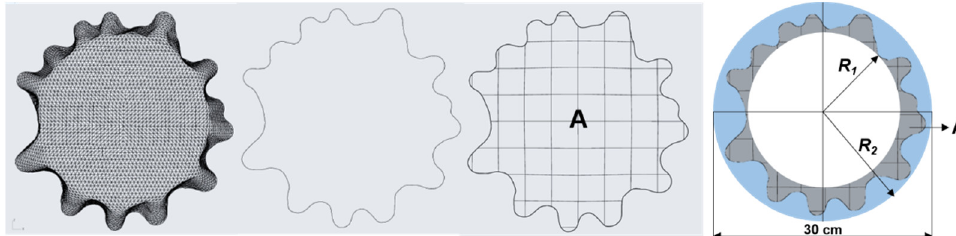
Figure 5. Computer processing of simulated drape samples in the Rhinoceros program.